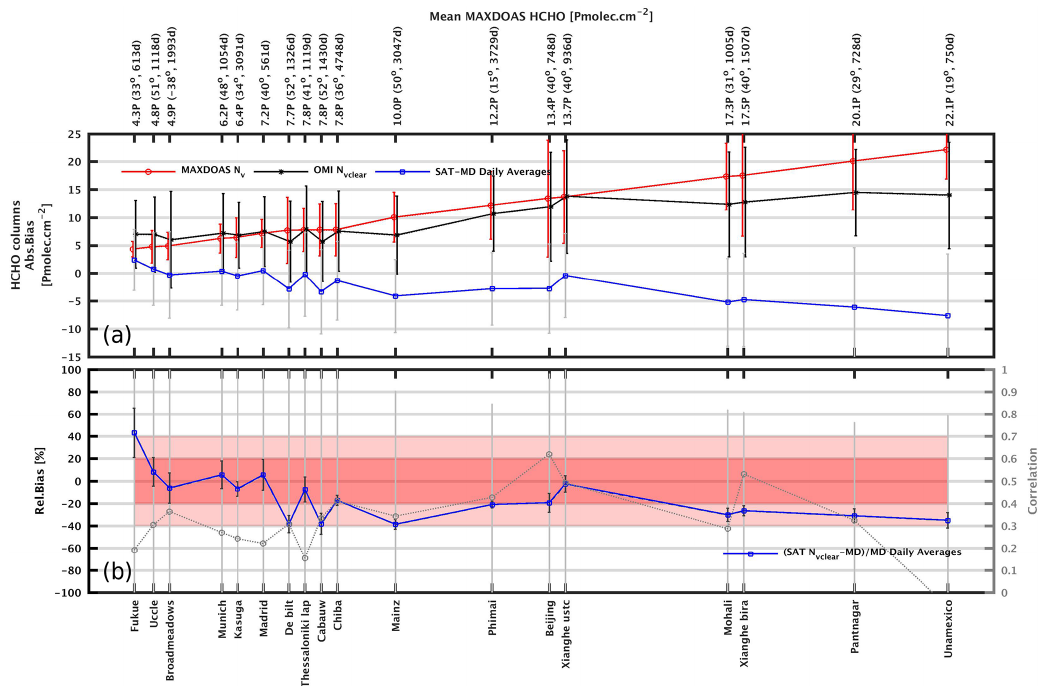
Figure 11. Same as Fig. 10 for daily averaged MAX-DOAS and OMI